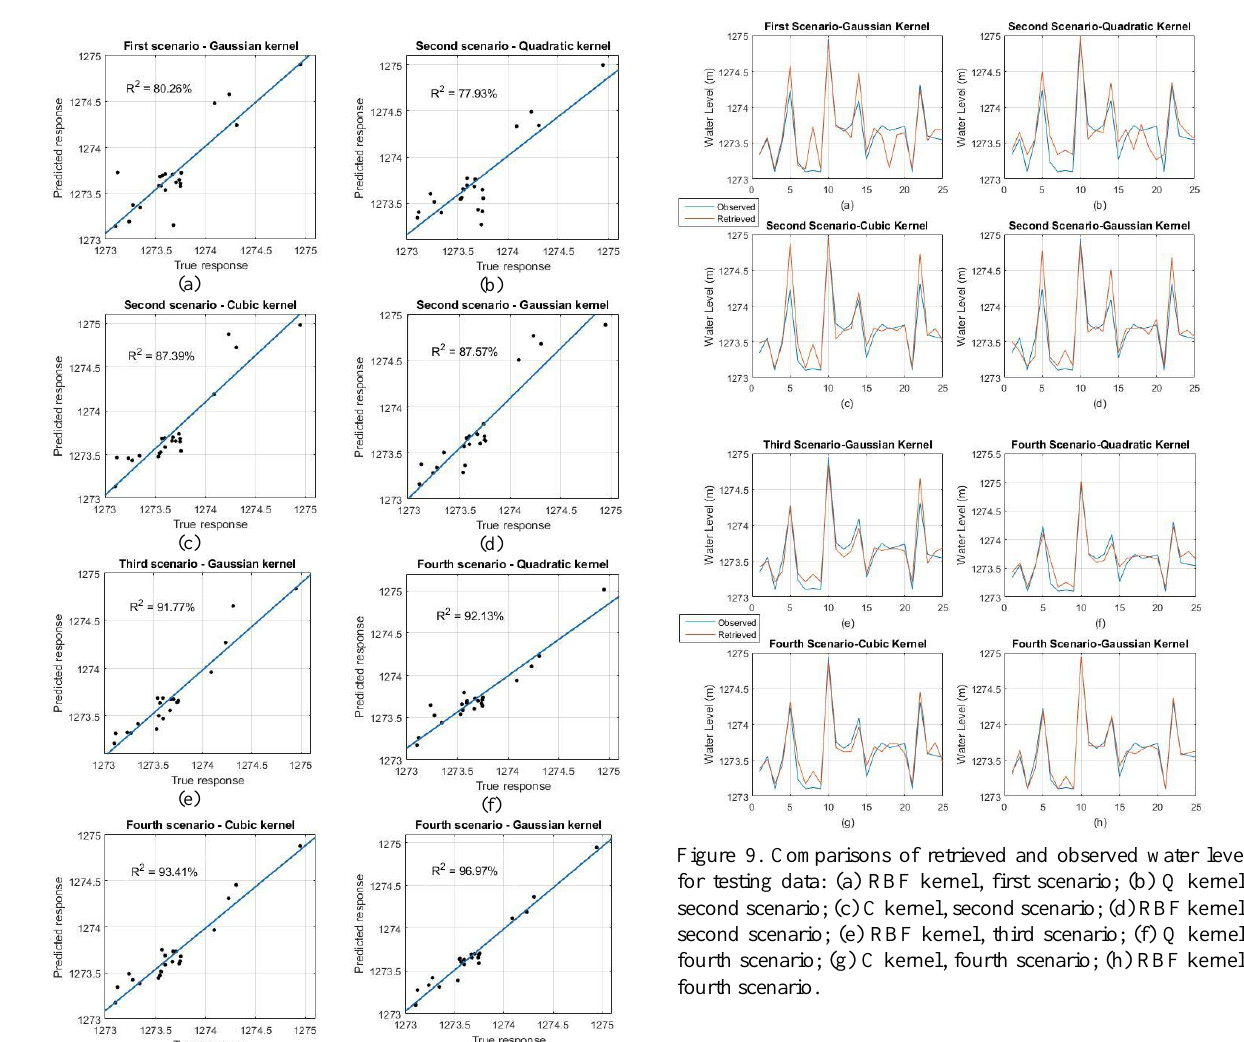
Figure 7. Correlation between retrieved and observed water level for training data: (a) RBF kernel, first scenario; (b) Q kernel, second scenario; (c) C kernel, second scenario; (d) RBF kernel, second scenario; (e) RBF kernel, third scenario; (f) Q kernel, fourth scenario; (g) C kernel, fourth scenario; (h) RBF kernel, fourth scenario.